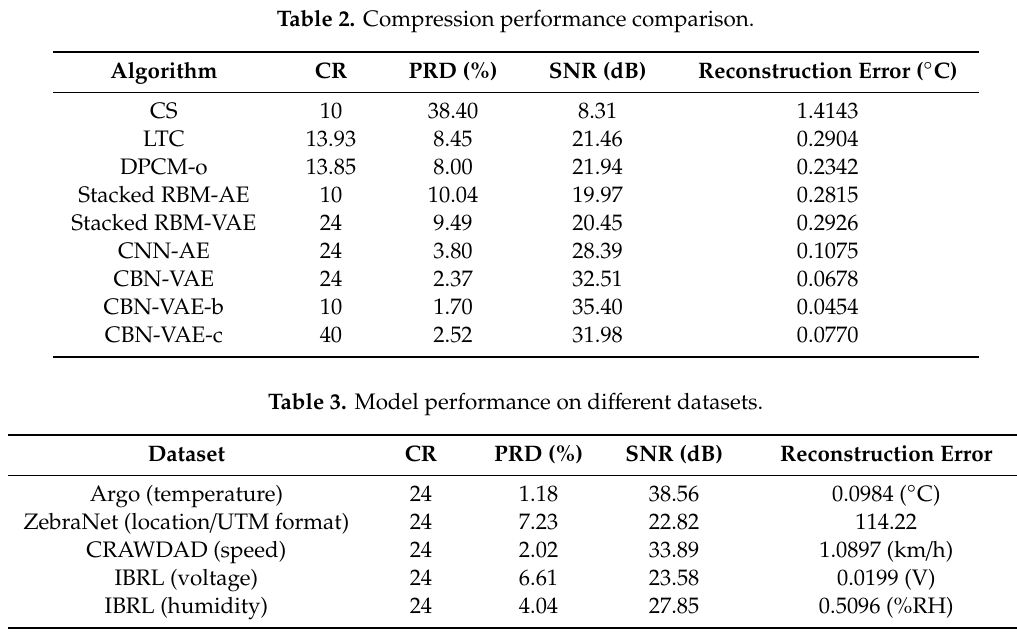
Table 2. Compression performance comparison.